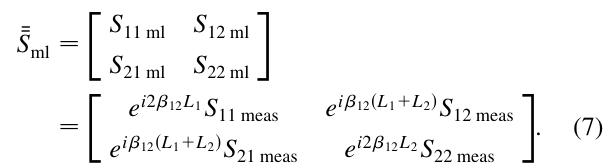
(cid:3)(cid:3) S meas , by operating a proper